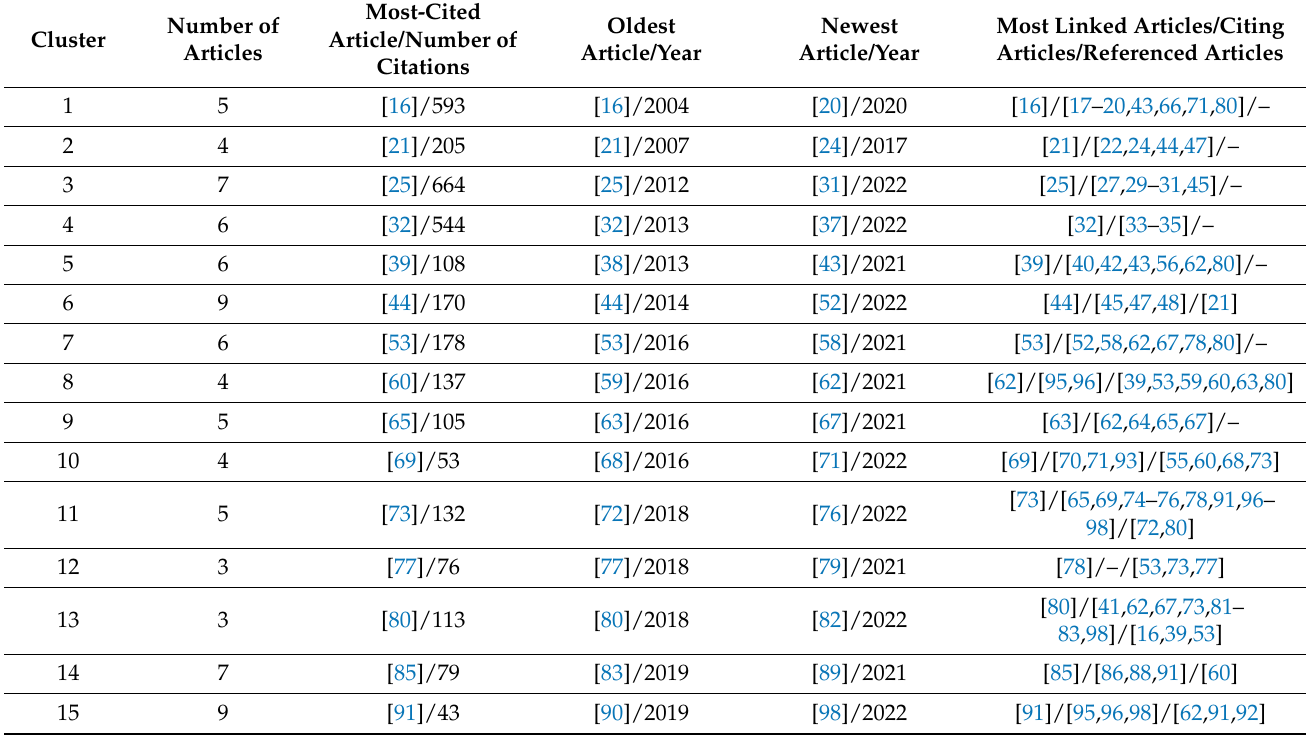
Table 1. Summary of article citation network by cluster show in Figure